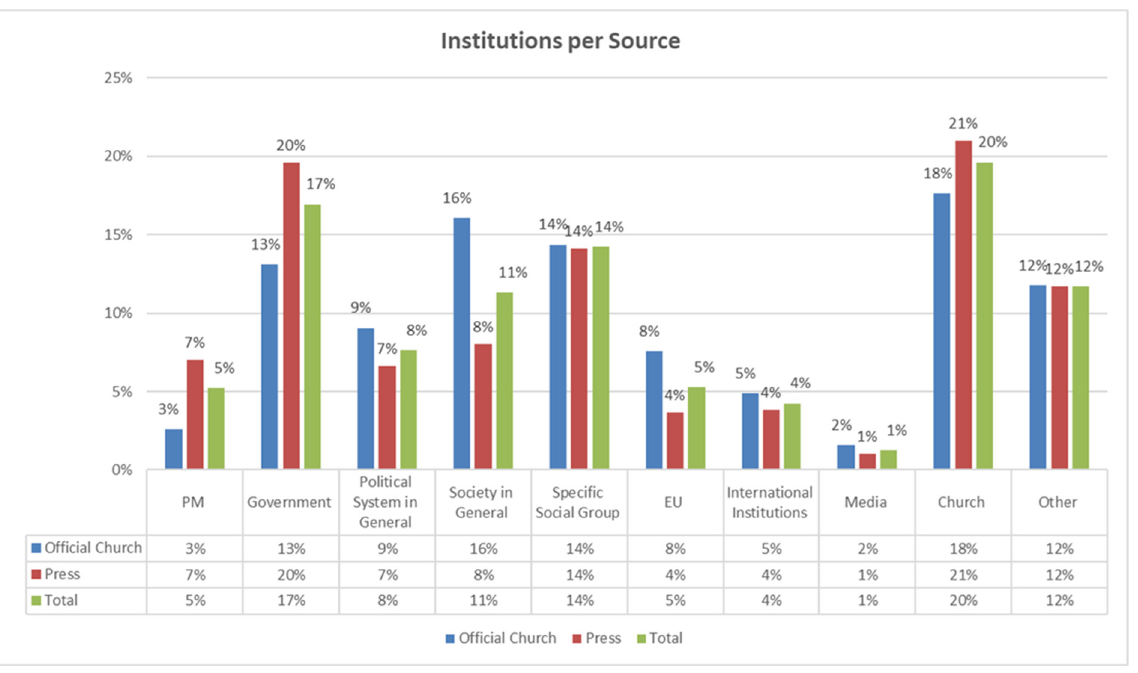
Figure 3. Institutions per source. Source: Official website of the CoG (www.ecclesia.gr, accessed on 17 March 2022) and newspapers (EFSYN and Kathimerini). Where the height of the bars with the same figures is slightly differentiated, this is due to the value rounding process performed by the statistical program used for the current research (IBM